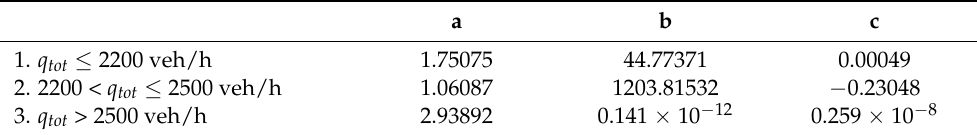
Table 2. Function parameters.